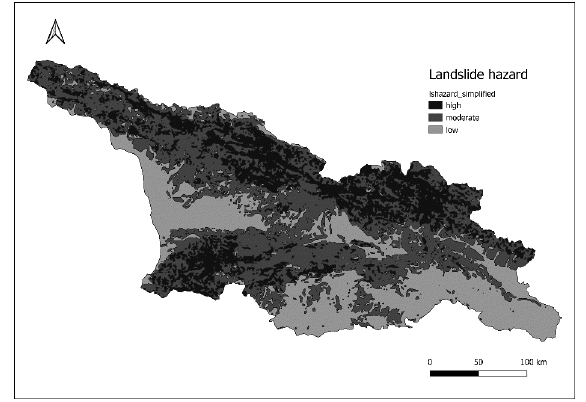
Figure 3. Landslide hazard (CENN, 2018)